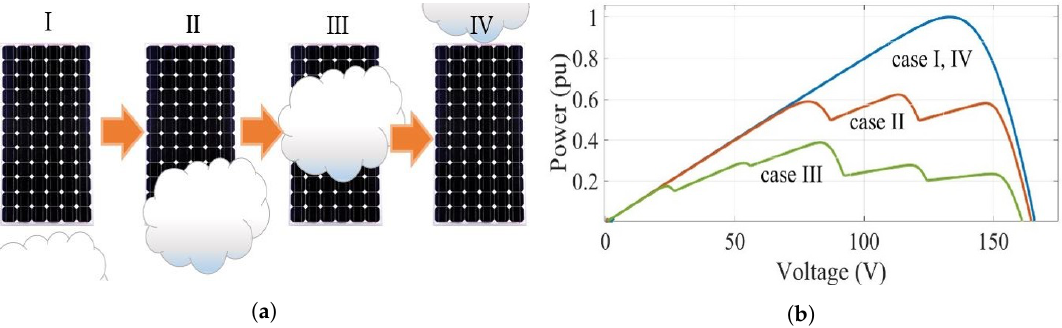
Figure 12. ( a ) Dynamic short-term testing diagram; ( b ) P–V characteristic curves under dynamic change by a passed